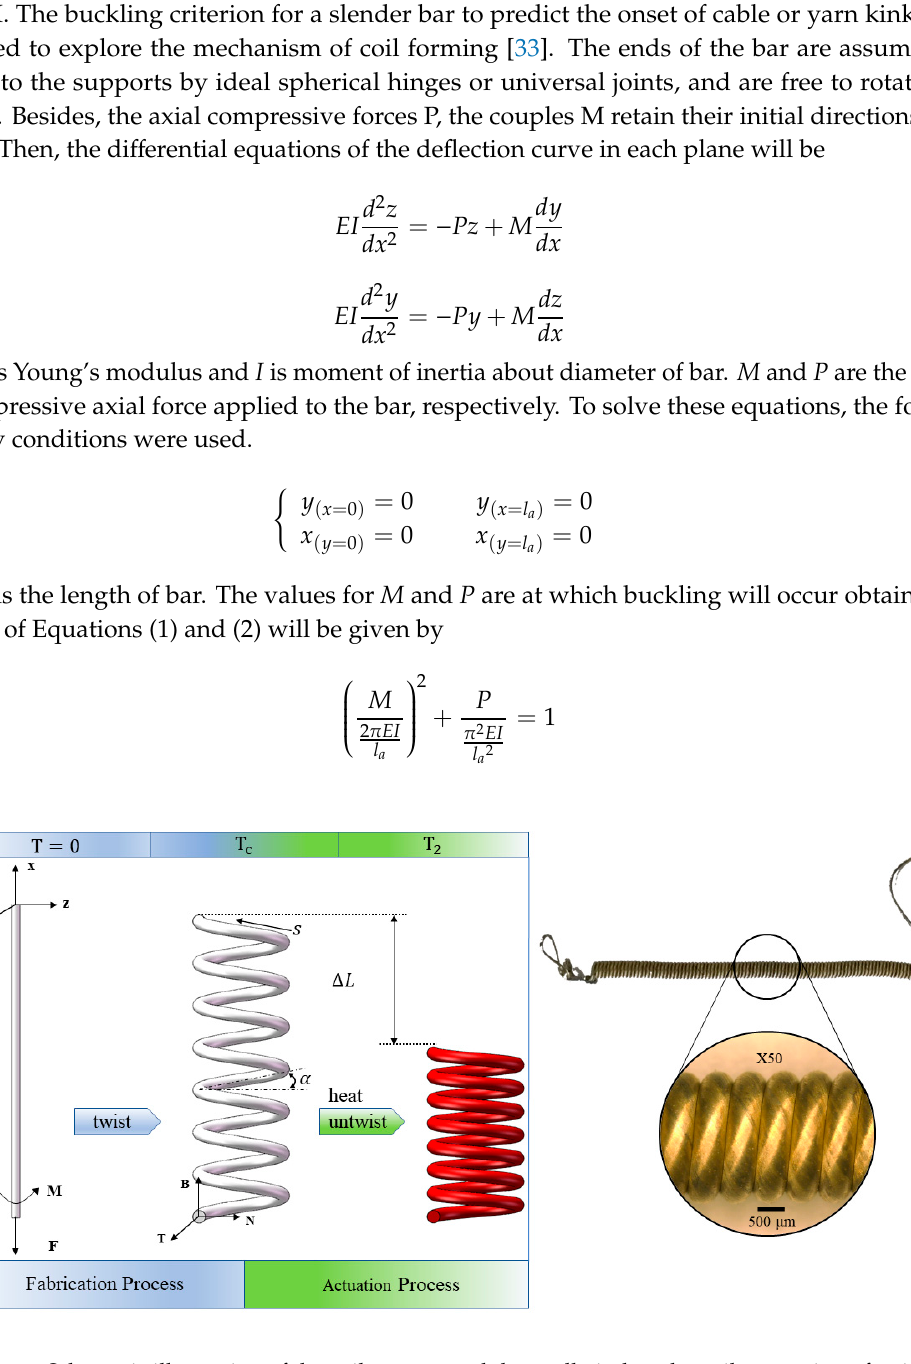
Figure 1. Schematic illustration of the coil process and thermally induced tensile actuation of twisted and coiled polymer (TCP) muscle: ( a ) schematics of the TCP fabrication and actuation process. The fabrication process could be understood by considering a slender bar subjected to the action of a tensile force F and a twisting couple M. In the actuation process, TCP muscles will untwist when heated with twist number turning into length change of TCP muscles. ( b ) microscope images of TCP muscle.